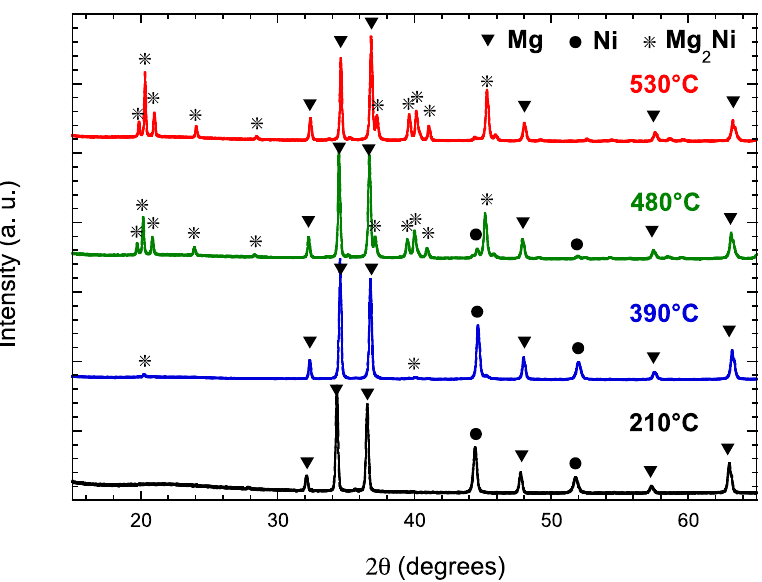
Figure 6. XRD patterns acquired on polished surfaces, on the upper horizontal surface of the Mg-Ni samples forged at increasing temperatures.